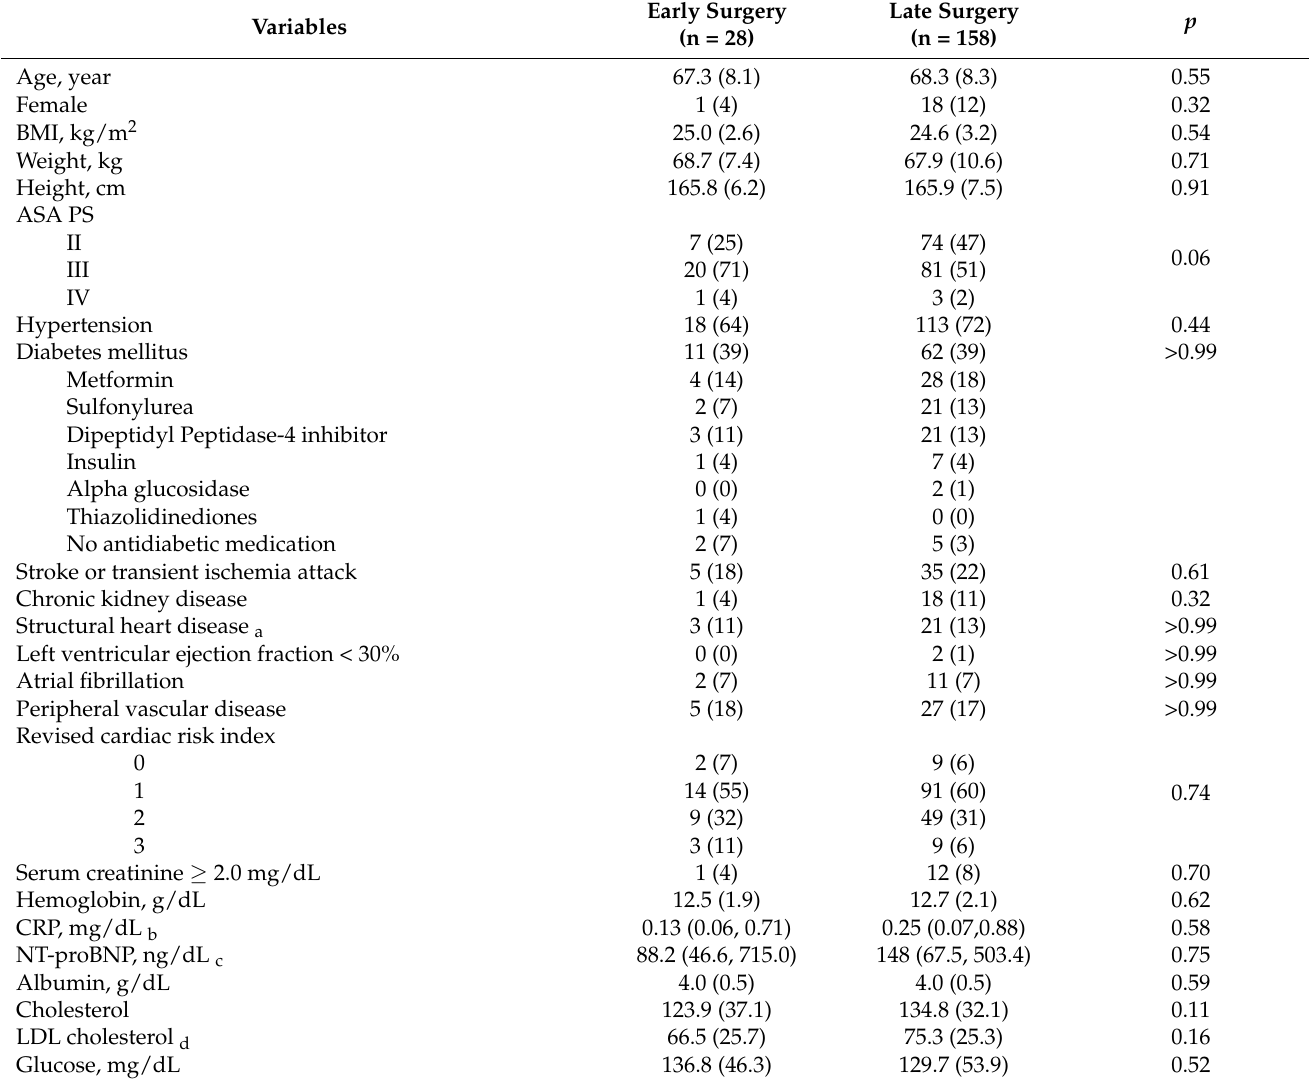
Table 1. Patient and operative characteristics between early and late surgery (raw